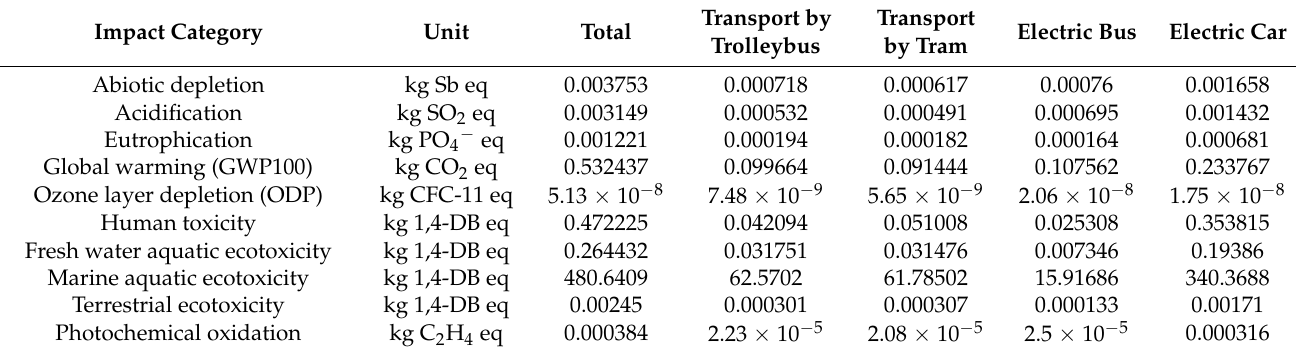
Table 10. The results of characterizing the environmental impacts of electric